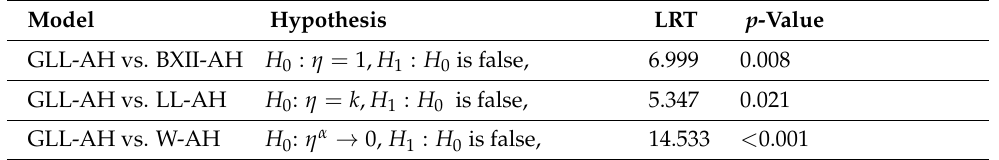
Table 4. LRT test for the GH model and its submodels.